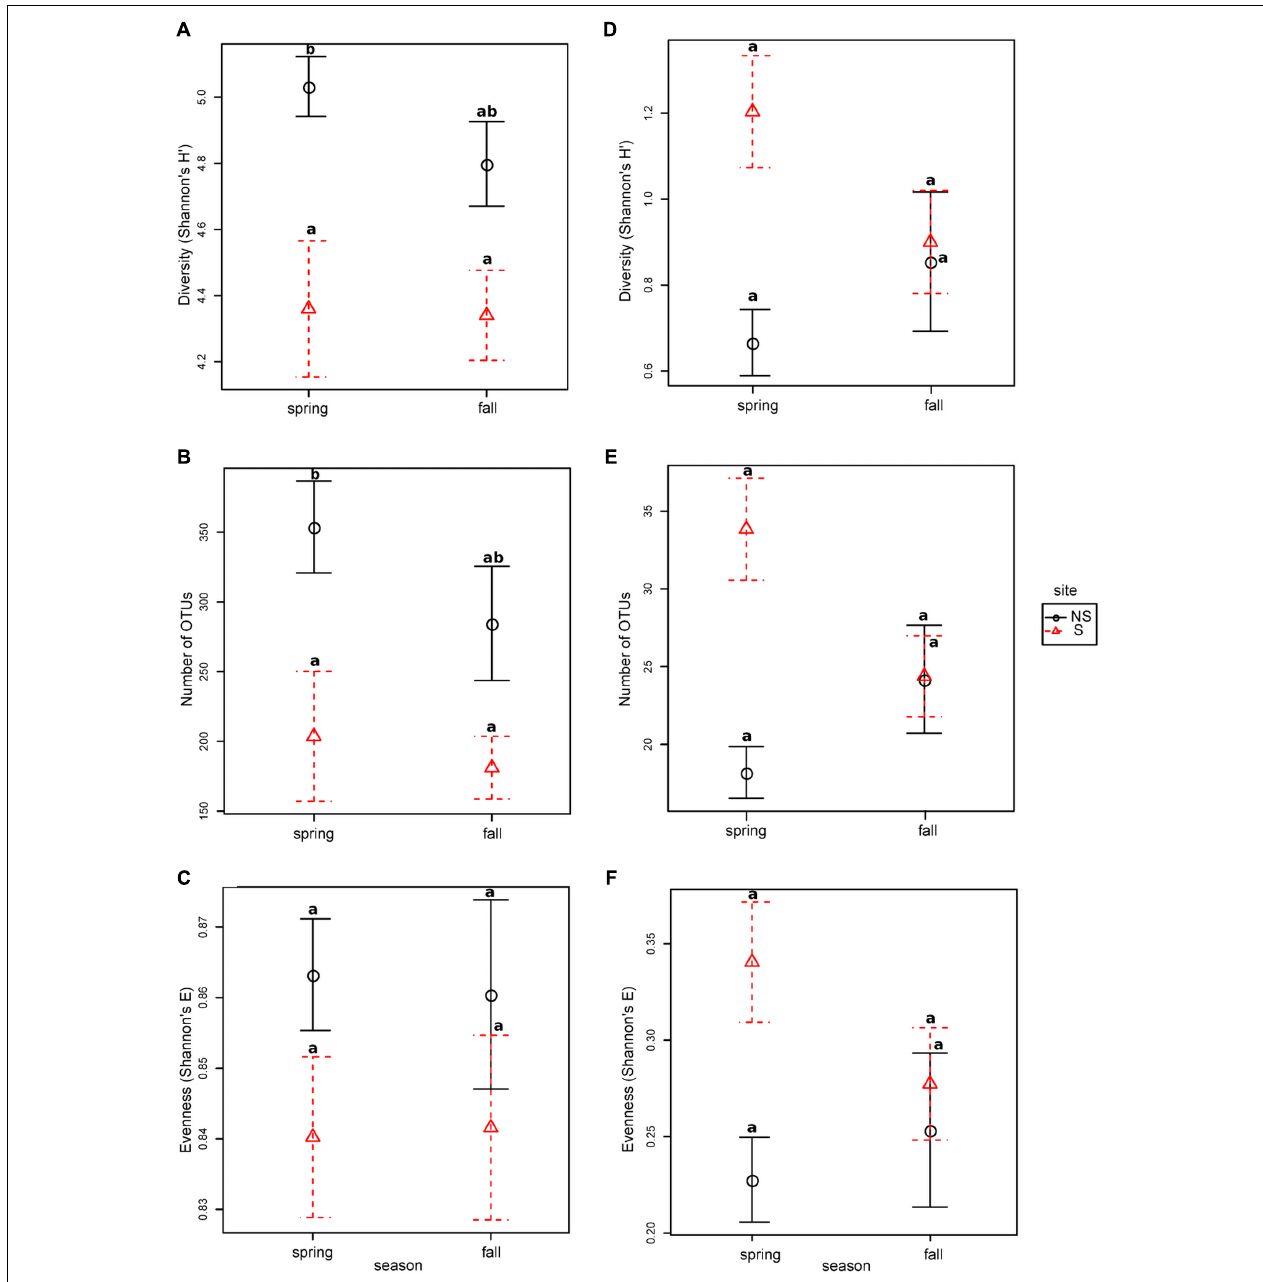
FIGURE 1 | Species richness, diversity and evenness in different seasons and sites for OTUs constructed at 0.03 dissimilarity for bacterial and fungal sequences: panels (A,D) Shannon’s H’, (B,E) – observed number of OTUs, (C,F) – Shannon’s E. Robust ANOVA test with the Tukey’s post hoc analysis were used to assess significance of differences between sites and seasons. Variants labeled with the same letters are not significantly different ( p ≤